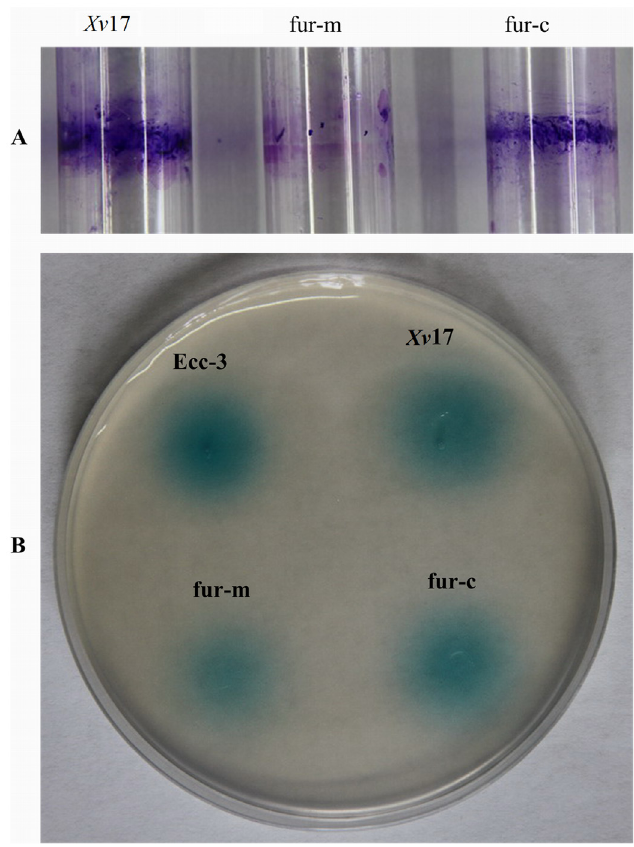
Fig 3. Effect of fur on biofilm formation (A) and quorum sensing (QS) signals in Xv (B). Biofilm formation is indicated by the ring formed on the surface of glass test tubes. QS signal expression was indicated by blue halos 12 – 18 h after each strain was spotted and after incubation on ABM plates at 28°C. A QS assay was used to detect signaling molecules as a blue halo. Xv 17: wild-type Xv strain; fur-m: fur mutation strain of Xv 17; and fur-c: fur complementation strain of fur-m. Ecc3: E . carotovora subsp. carotovora strain 3 as a positive control for expression of QS signals.